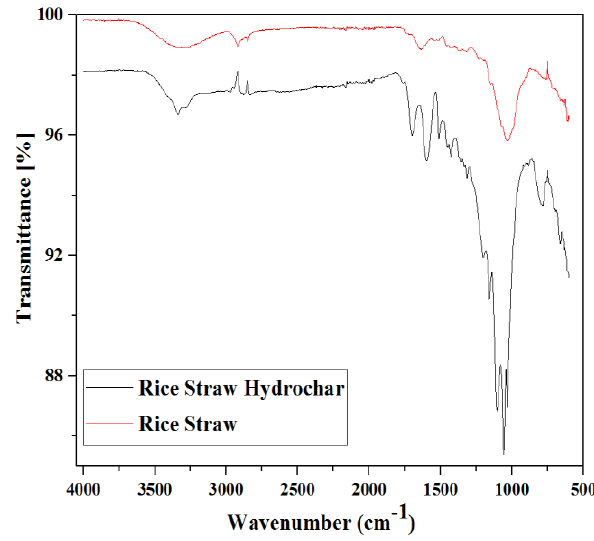
Figure 6. The Fourier transform infrared (FTIR) analysis of rice straw and optimized hydrochars.